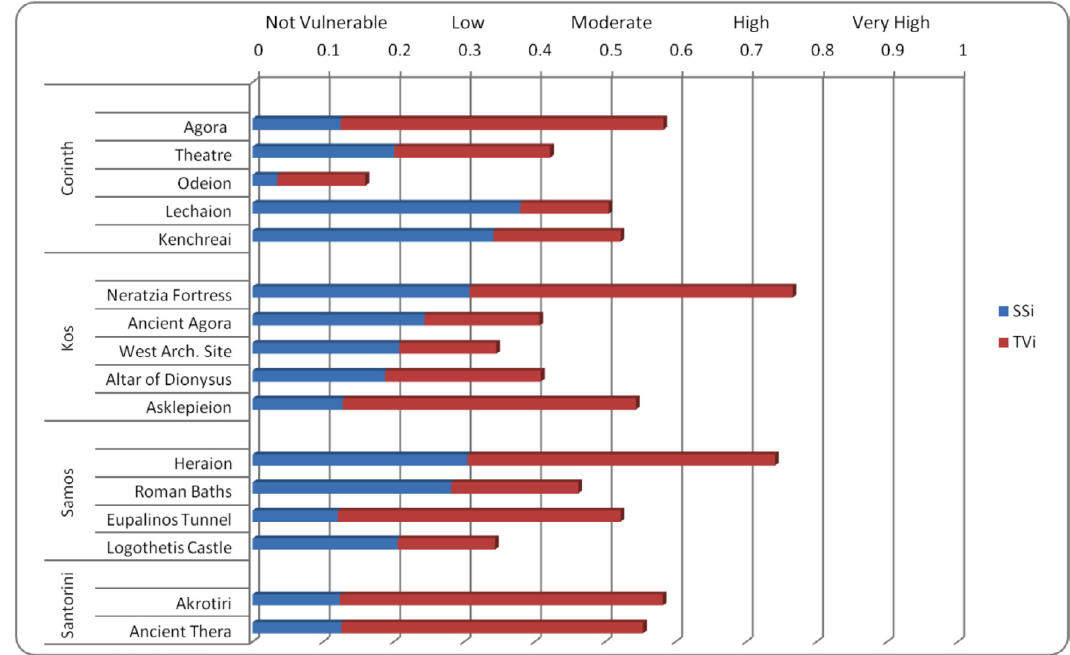
Figure 11. The A.S.V.I. index with the contribution of SSi and TVi for the archaeological sites in this